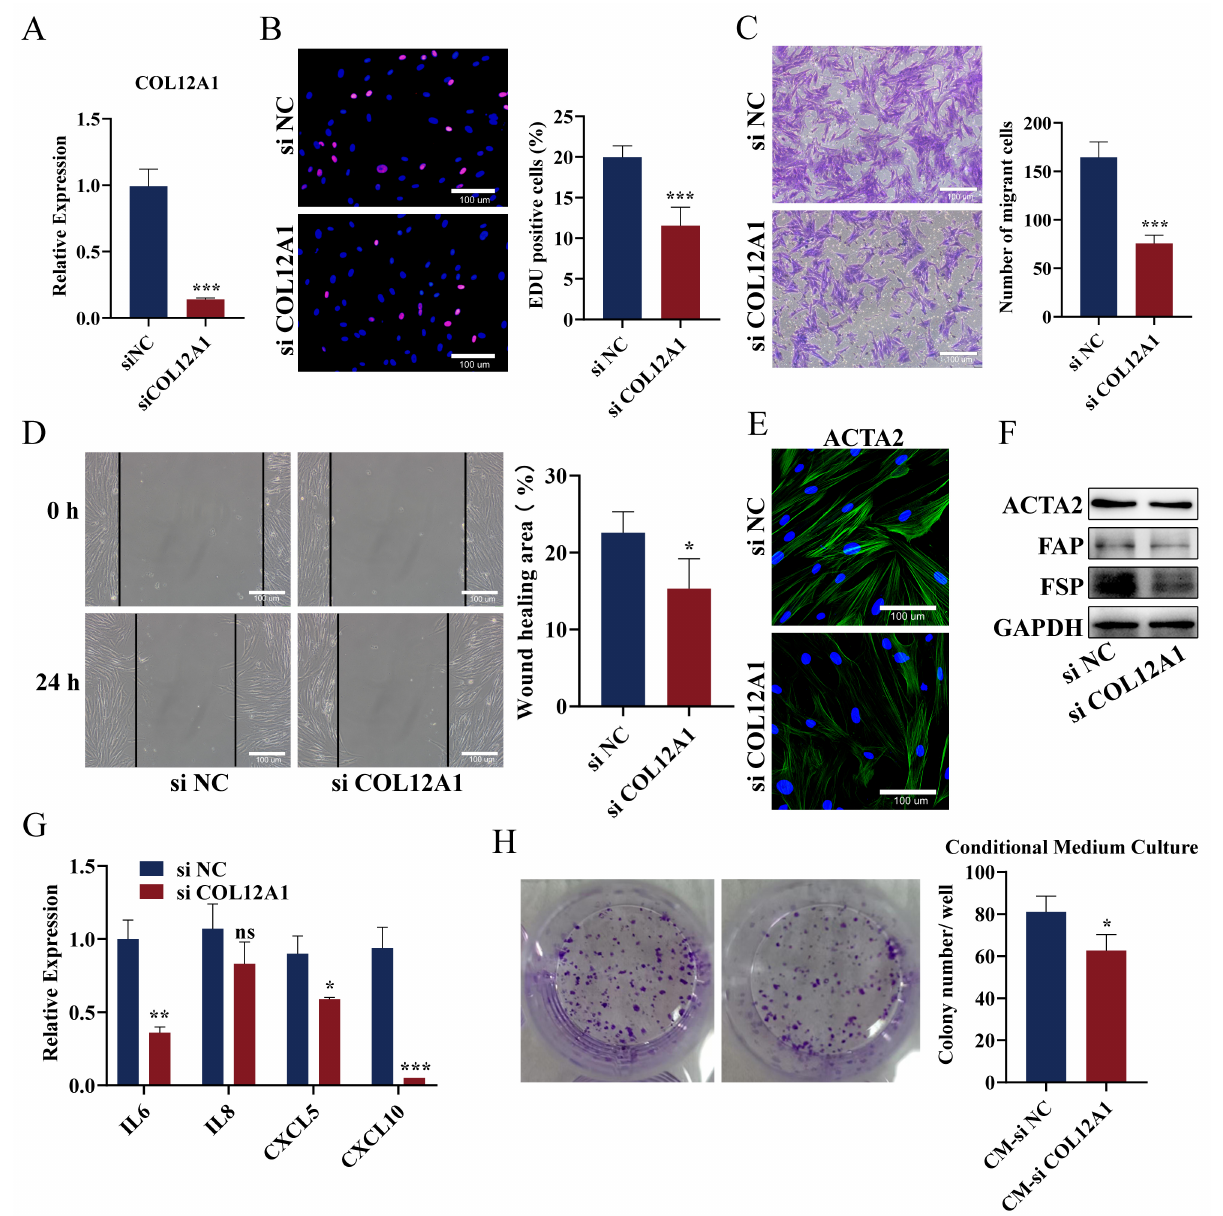
Figure 9. Verification of the function of COL12A1 in CAF and tumor cells. ( A ) COL12A1 mRNA expression in siCOL12A1- and siNC-transfected CAFs. ( B ) EDU assay indicated the proliferation ability of CAFs in the siCOL12A1 and siNC groups. ( C ) Transwell assay analyzed the CAFs migration after COL12A1 knockdown. ( D ) Wound healing checked the CAFs migration in siCOL12A1- and siNC-transfected CAFs. ( E ) Immunofluorescence intensity of ACTA2 and the number of ACTA2 fibers were checked after COL12A1 knockdown in CAFs. ( F ) Western blot demonstrated the protein level of ACTA2, FAP, and FSP expressions after COL12A1 knockdown in CAFs. ( G ) qPCR checked IL6, IL8, CXCL5, and CXCL10 expressions in siCOL12A1- and siNC-group CAFs. ( H ) Collected the supernatant from siCOL12A1- and siNC-group CAFs and then added it to incubate Panc-1 cells. Detected the clone formation of Panc-1 cells with conditional medium (*, p < 0.05, **, p < 0.01, ***, p < 0.001, ns,